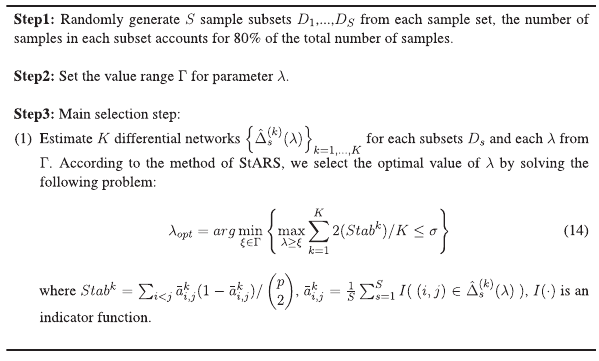
Algorithm 1. Complete Algorithm for WJSDM (8) Algorithm 2. Tuning Parameter Selection for